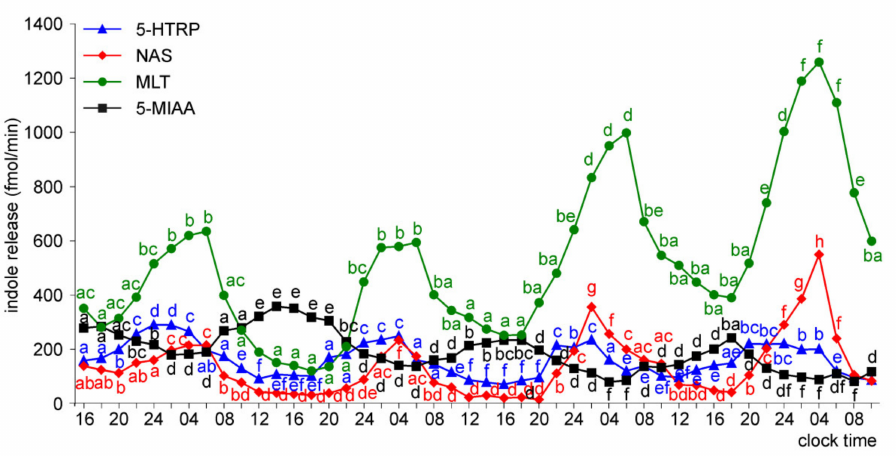
Figure 9. Release of 5-HTRP, NAS, MLT, and 5-MIAA (means, n = 3) from pineal organs of ED 26 embryos incubated under a 12L:12D cycle. The same letters indicate means, which are not significantly different between time-points.